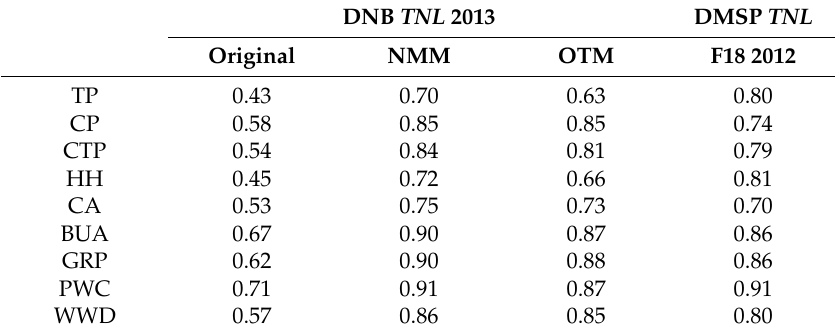
Figure 4. Scatter plots of total night light ( TNL ) vs. socio-economic parameters (1st row: built-up area; 2nd row: gross regional product (GRP); 3rd row: power consumption) together with the fitting curve (in red) from regression. TNL data used in the 1st, 2nd and 3rd column are derived from DNB composite data with NMM, the optimal threshold method (OTM) in 2013 and DMSP-OLS stable data in 2012, respectively. Red labels in the panel denote: GD, Guangdong; SD, Shandong; XZ, Xizang; JS, Jiangsu. Table 4. Correlation coefficients between TNL and socio-economic parameters. TNL ’s are derived from DNB composite data with or without noise filtering and DMSP-OLS F18 stable data,